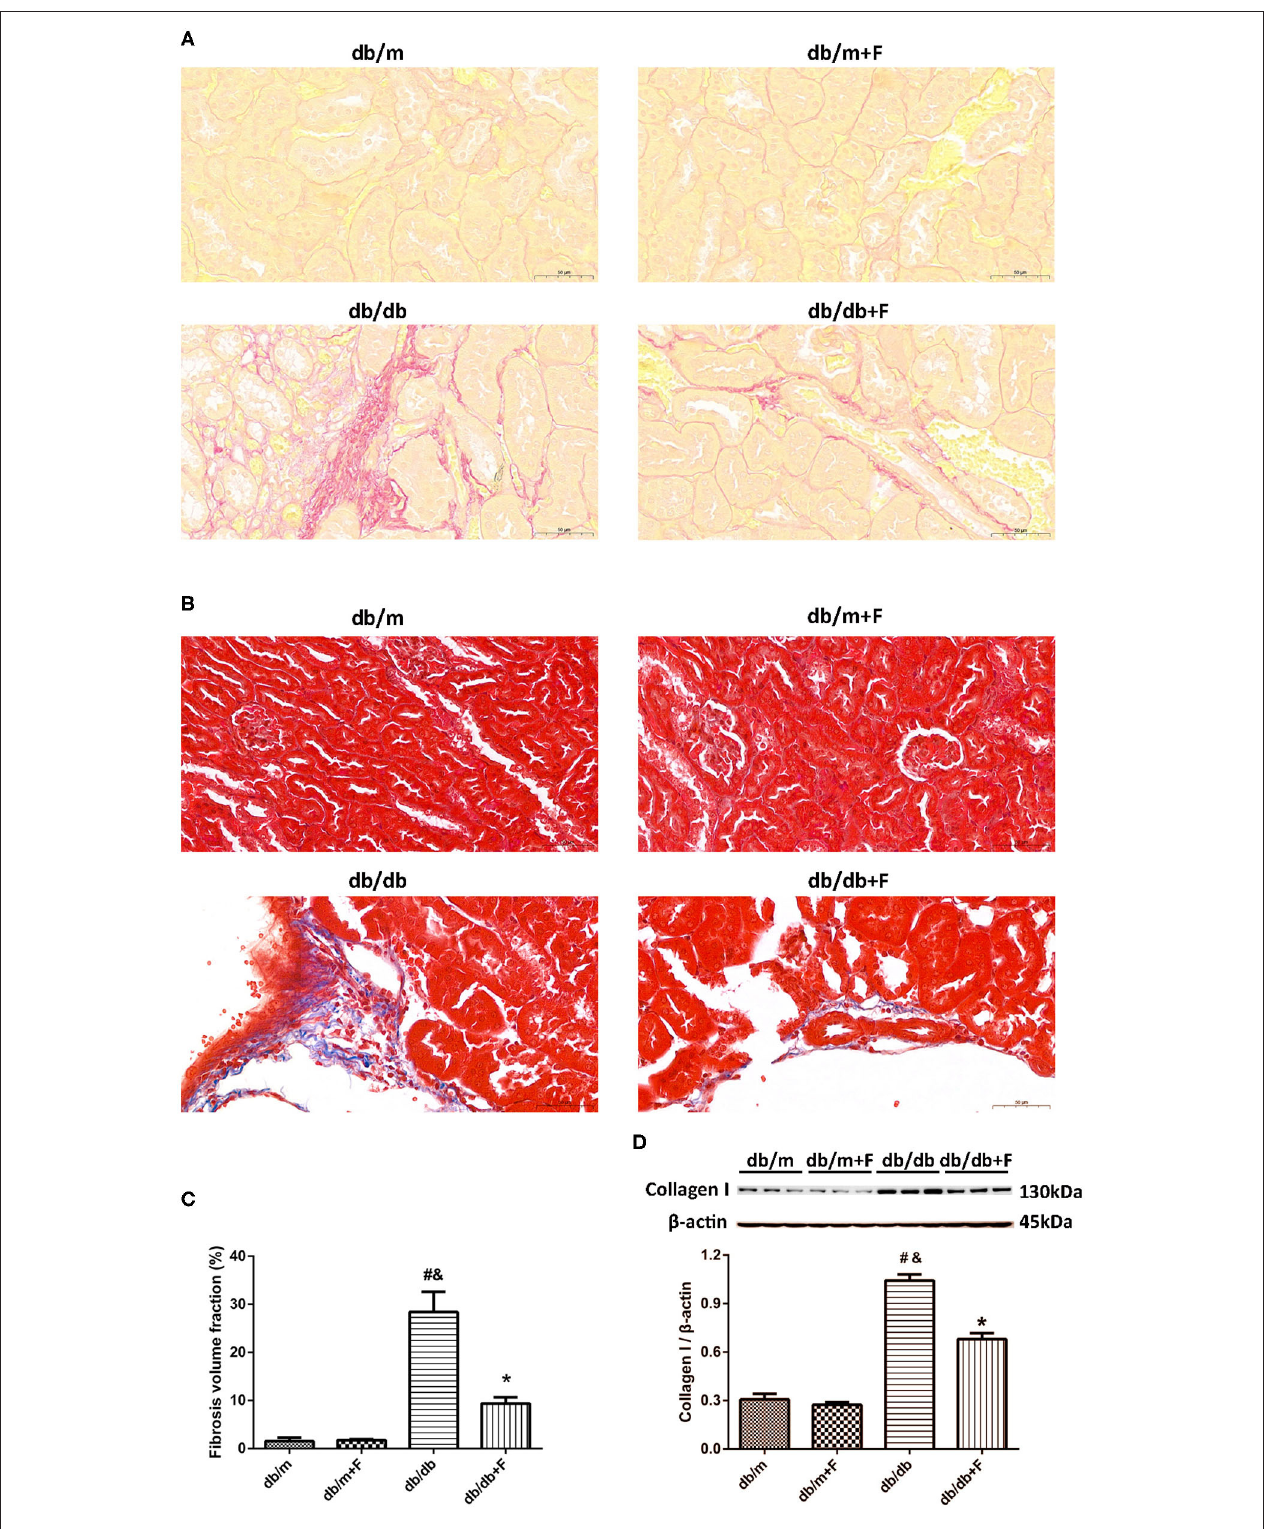
FIGURE 3 | Renal fibrosis in db/m, db/m + F, db/db, and db/db + F groups. (A–C) Representative photographs and quantification of renal fibrosis measured by Sirius red staining (A) and Masson’s staining (B) . (D) Representative photographs and quantification of collagen I in mouse kidneys detected by western blot. n = 6 mice/group. # P < 0.05 vs. db/m group; & P < 0.05 vs. db/m + F group; * P < 0.05 vs. db/db group. Db/m, db/m mice without fenofibrate treatment; db/m + F, db/m mice with fenofibrate treatment; db/db, db/db mice without fenofibrate treatment; db/db + F, db/db mice with fenofibrate treatment. Data are means ± S.E.M.